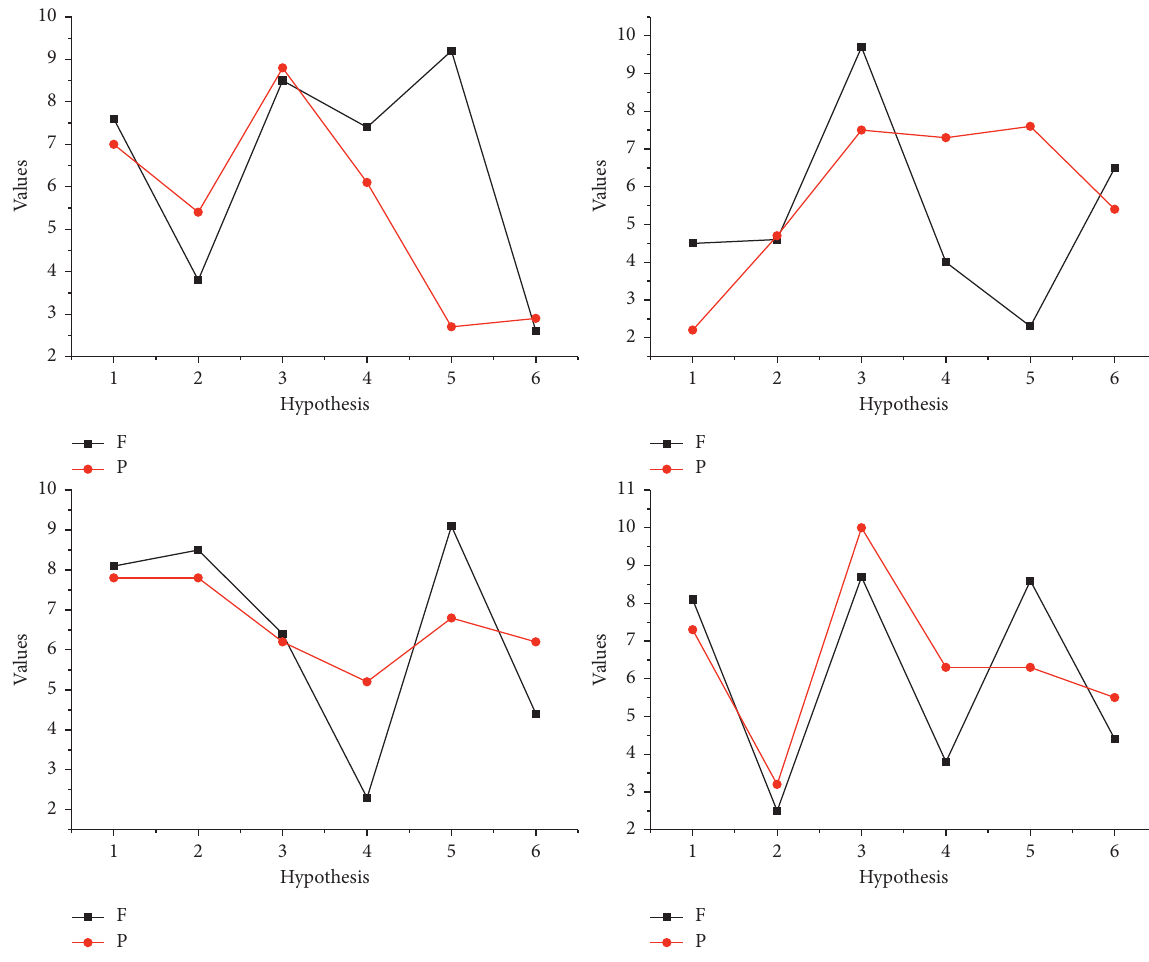
Figure 10: Causality test